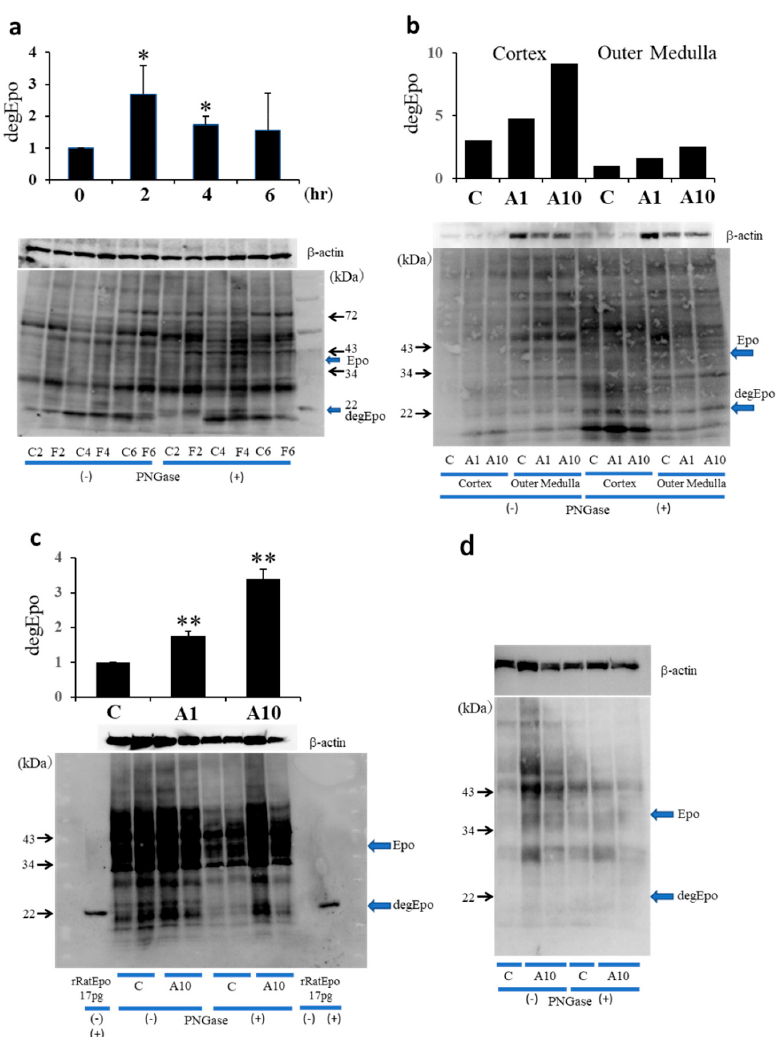
Figure 3. Effects of fludrocortisone and ATII on Epo protein expression in the kidney and liver. ( a ) Effects of fludrocortisone on Epo production in the kidney. Fludrocortisone increased deglycosylated Epo protein expression at 2 and 4 h after the injection. The levels returned to basal values after 6 h. ( b ) ATII dose-dependently increased deglycosylated Epo protein expression in the renal cortex and outer medulla. The effects were larger in the renal cortex than in the renal outer medulla. ( c ) ATII increased deglycosylated Epo production in the renal cortex by 1.6- and 3.4-fold by 1 and 10 mg/kg, respectively. ( d ) In contrast, deglycosylated Epo production was not observed in control and ATII-injected livers. Recombinant rat Epo is shown as the control in Figure 3c. Glycosylated Epo and deglycosylated rat Epo were used in lane 1. Glycosylated Epo and deglycosylated Epo were used in lanes 11 and 12, respectively. * p < 0.05, ** p < 0.01 by a non-parametric analysis using the Kruskal–Wallis test and multiple comparisons by the Shirley–Williams’ test.